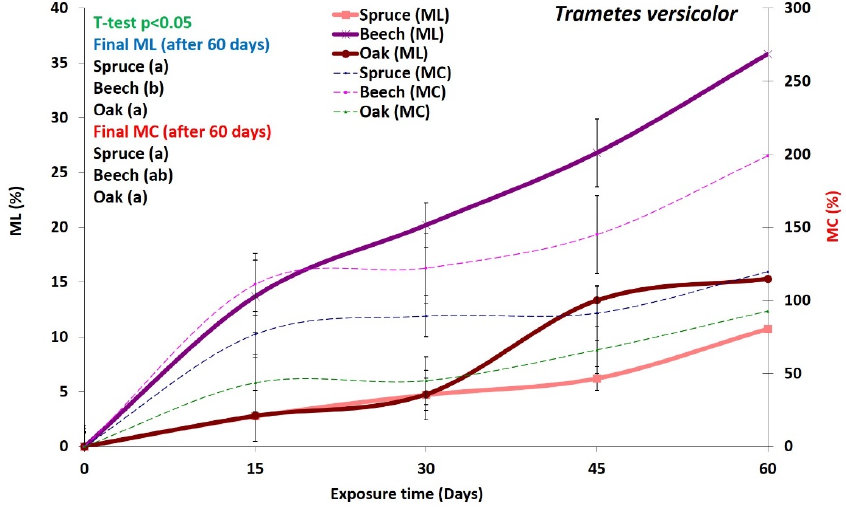
Figure 2. Mass loss (ML) and moisture content (MC) of wood decayed by the white-rot fungus Trametes versicolor for 60 days incubation. Average of twelve replicates ± SD. t -test p < 0.05.